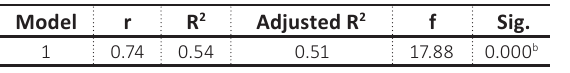
Table 2. Maslow’s hierarchy of needs and multiple regressions test